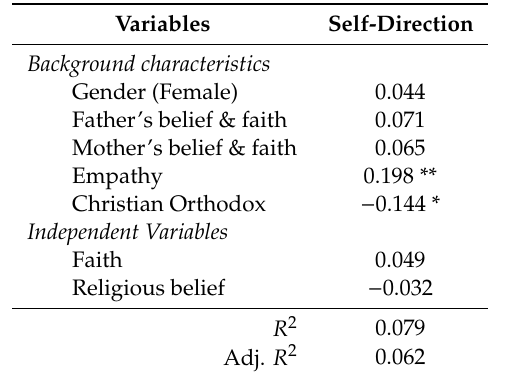
Table 2. Regression analyses for self-direction with weights ( β ) for each variable and total explained variance ( R 2 and adjusted R 2